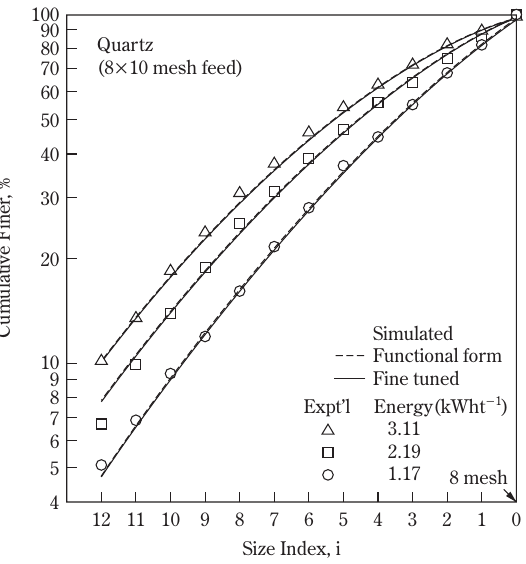
Fig. 8 Experimental and simulated size distributions of quartz ground in a high-pressure roll mill at different energy lev-